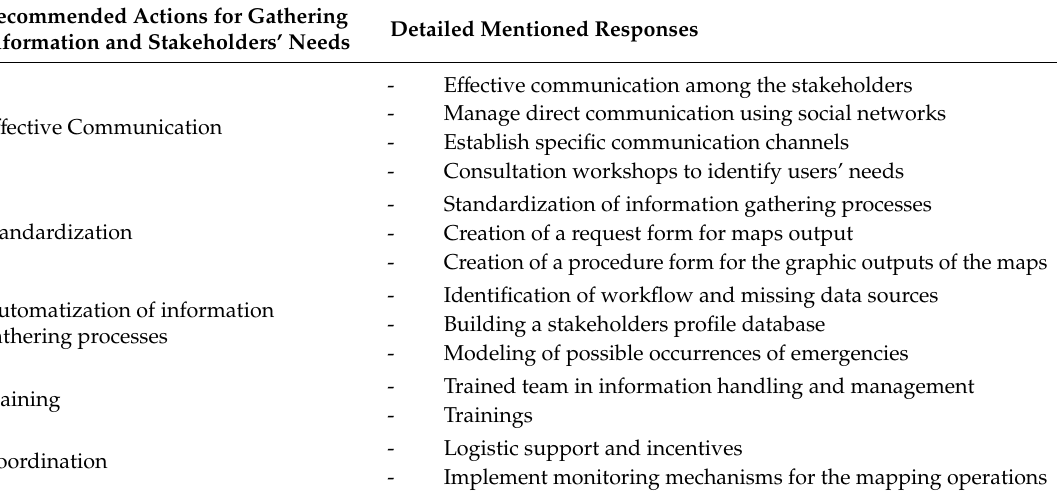
Table 2. Recommendations for anticipating EIGEO users’ needs (a) (Q14)